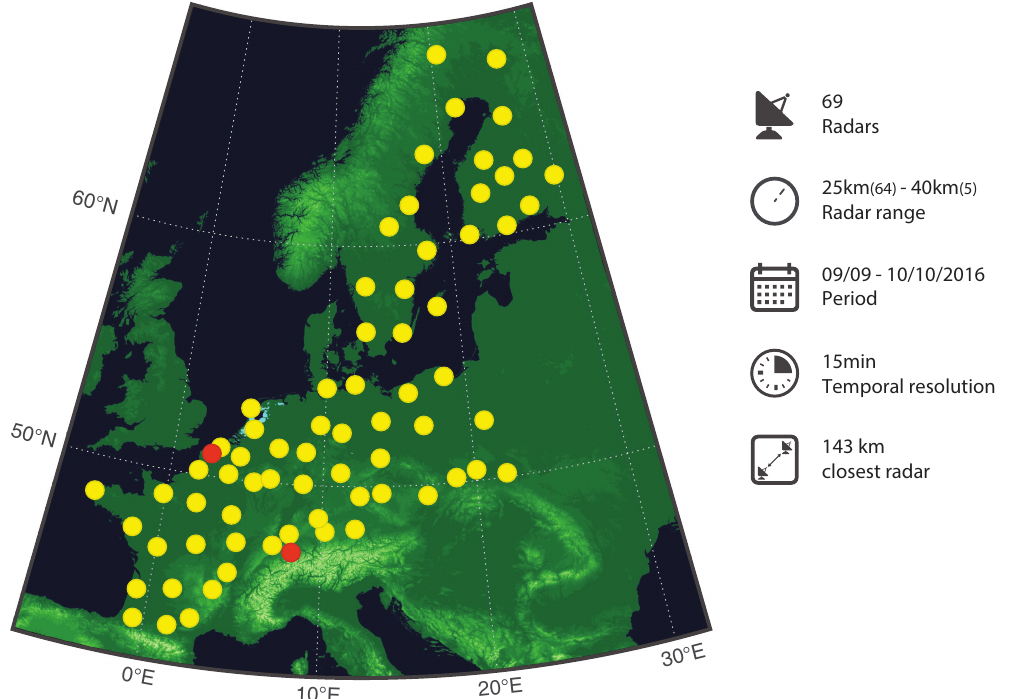
Figure 1. ( Left ) Locations of weather radars of the European Network for the Radar surveillance of Animal Movement (ENRAM) network, whose fall 2016-data were used in this study (yellow dots) and the two dedicated bird radars for validation (red dots). ( Right ) Key characteristics of the dataset used.